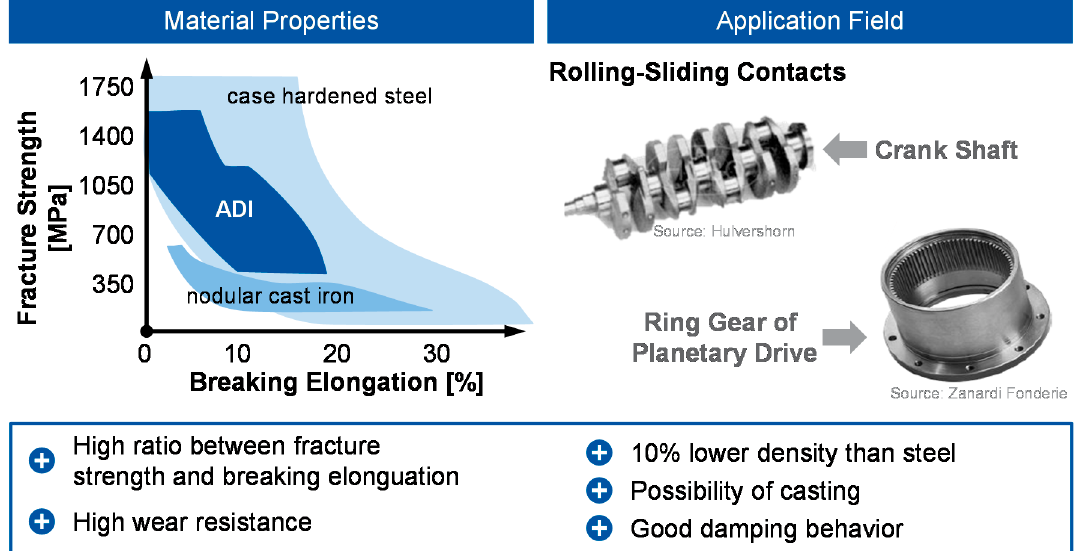
Figure 1. Introduction and motivation of austempered ductile iron (ADI) in applications [2].